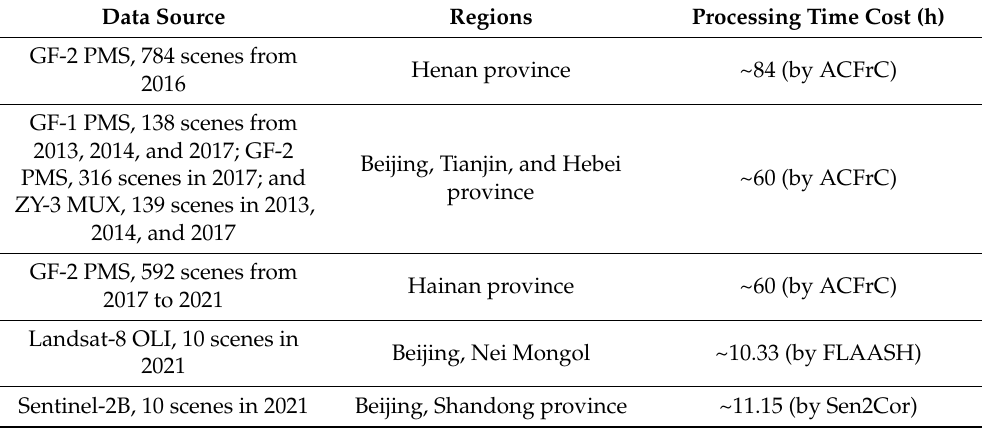
Table 7. Processing details for different data